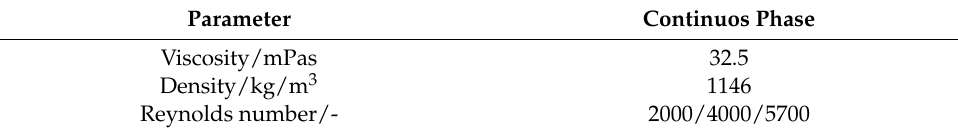
Table 2. Process